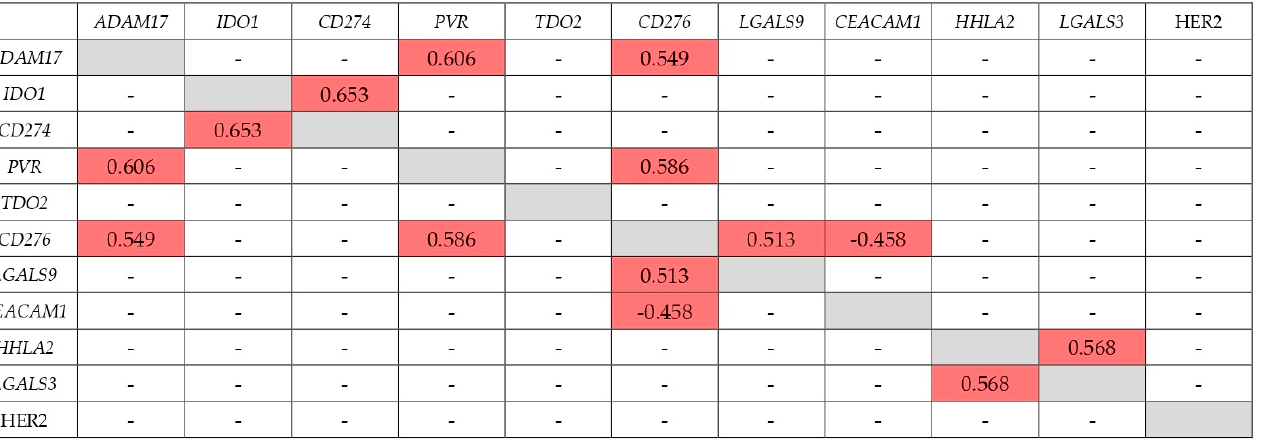
Figure 2. Correlation of expression at stage I + II (early GC). significant correlation; there is no significant correlation.